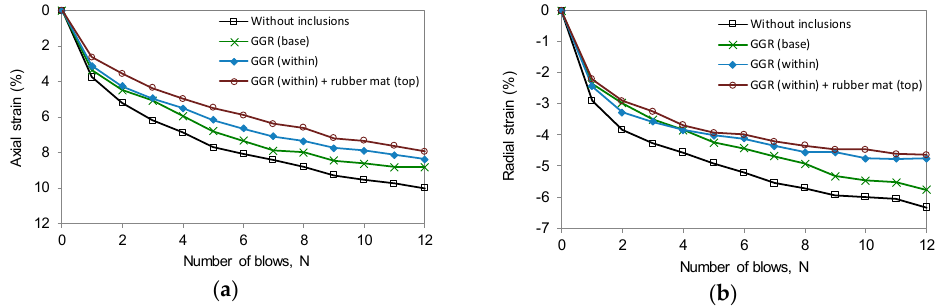
Figure 9. Evolution of ballast permanent deformations over number of blows: ( a ) Axial deformations; ( b ) Radial deformations.